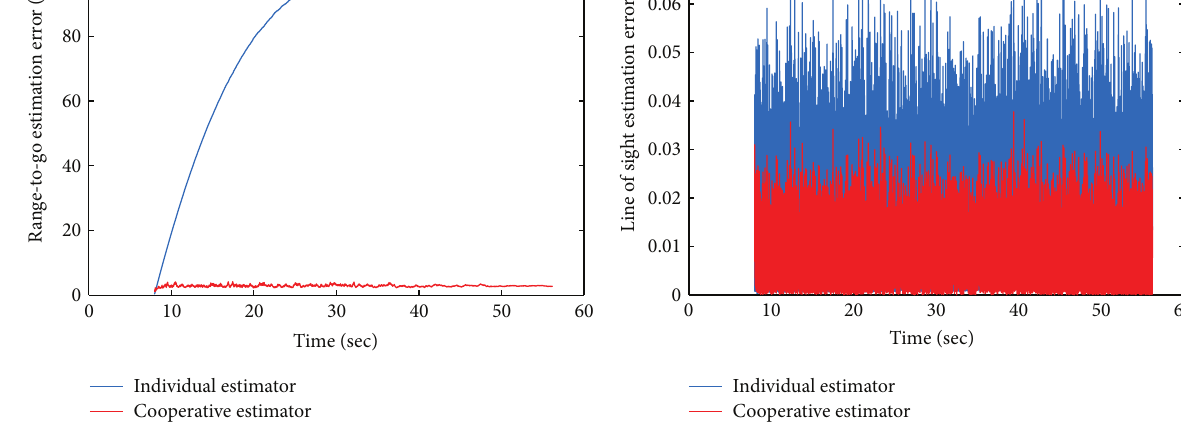
(b) Average norm of the line of sight estimation error versus time in terminal phase for individual and collaborative estimators